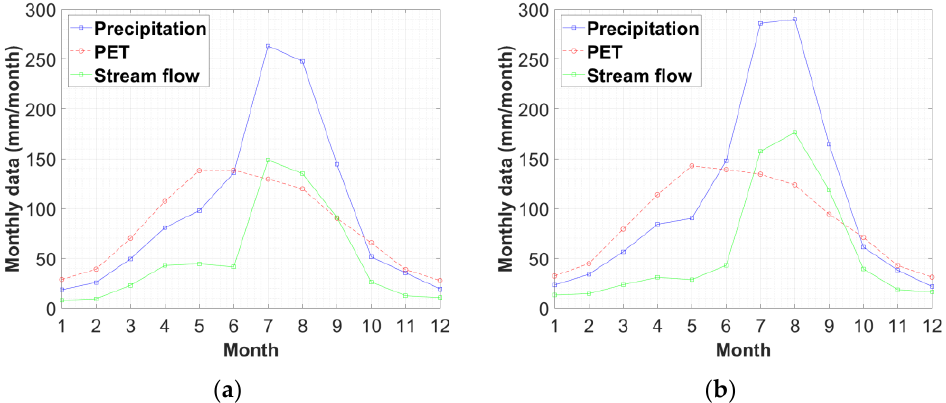
Figure 2. Monthly meteorological and hydrological data: ( a ) Andong Dam Basin; ( b ) Hapcheon Dam Basin.